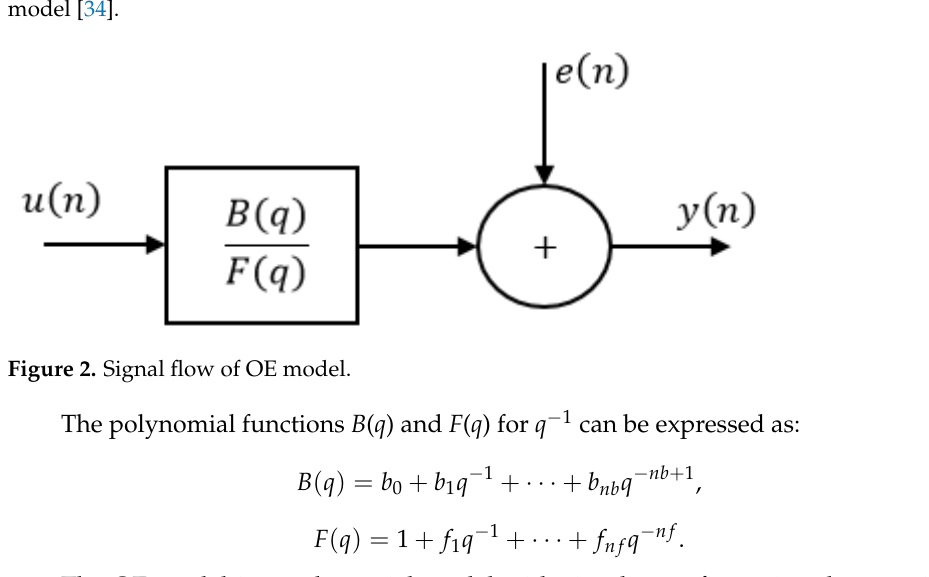
Figure 2. Signal flow of OE model.